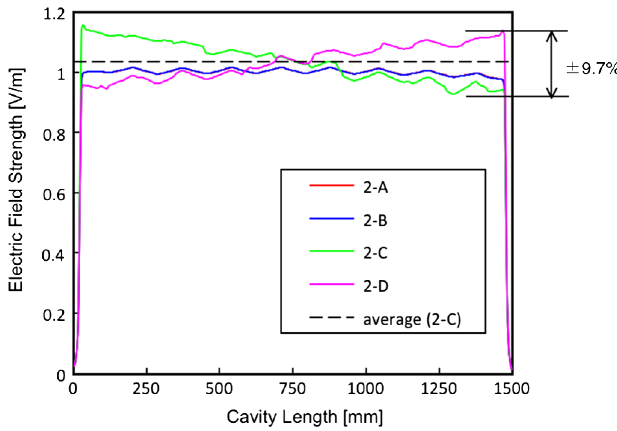
FIG. 11. A plot of the electric field strength as a function of the cavity length for different alignment errors that are normalized with respect to the average value of 2-C.